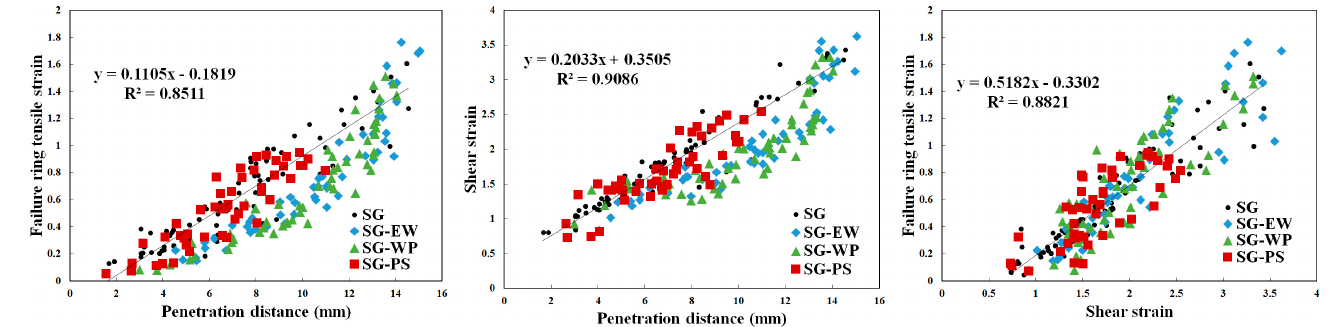
Figure 3. The correlation of textural properties related to the deformation of surimi gels. The trend line for each figure was based on surimi gel without any added ingredients.